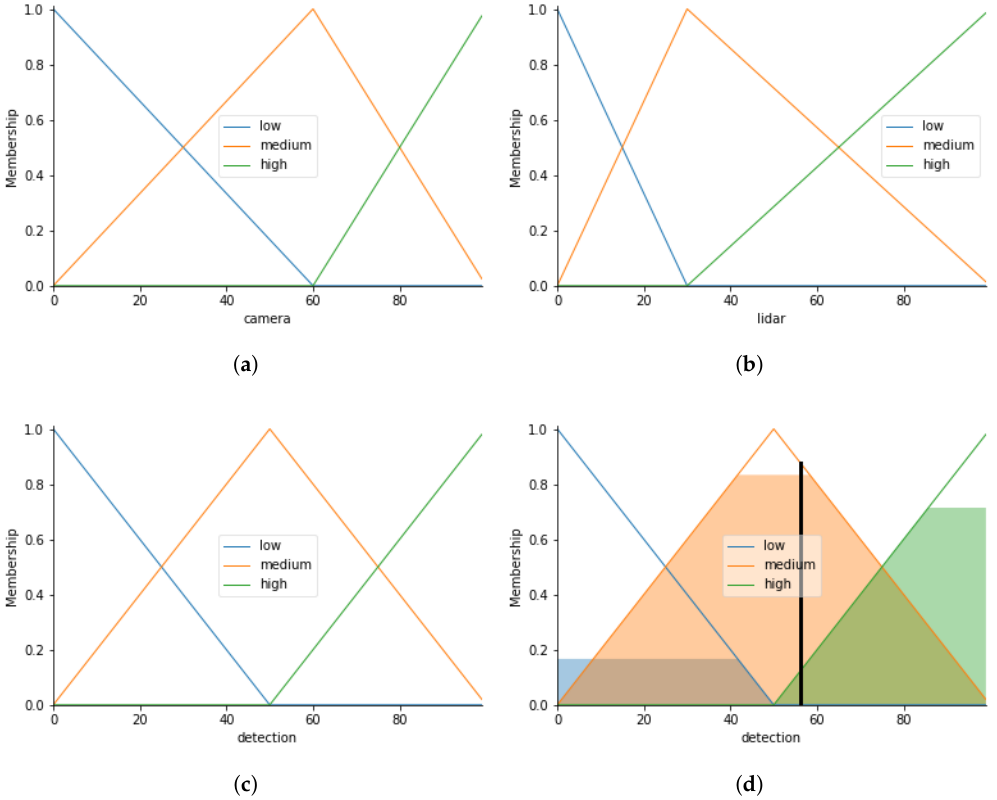
Figure 19. ( a ) Fuzzy membership function for camera. ( b ) Fuzzy membership function for LiDAR. ( c ) Fuzzy membership function for detection. ( d ) Fuzzy logic output. Combination of confidence scores from the camera and LiDAR using fuzzy logic. Figure best viewed in